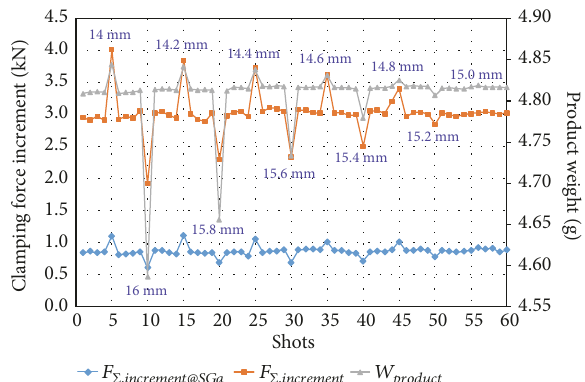
Figure 19: Shot-by-shot variation of clamping force quality index and product weight for various V/P switchover